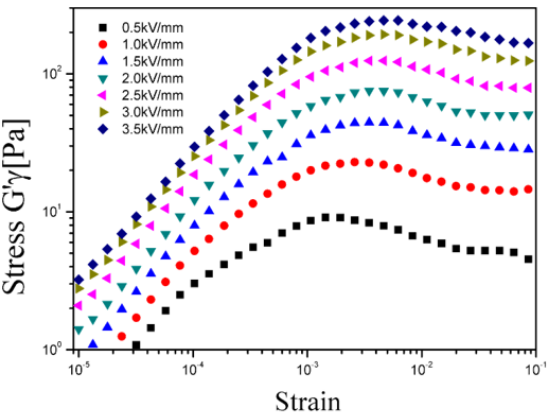
Figure 4. In-phase stress component ( G' γ ) as a function of strain replotted using the data presented in Figure 3.